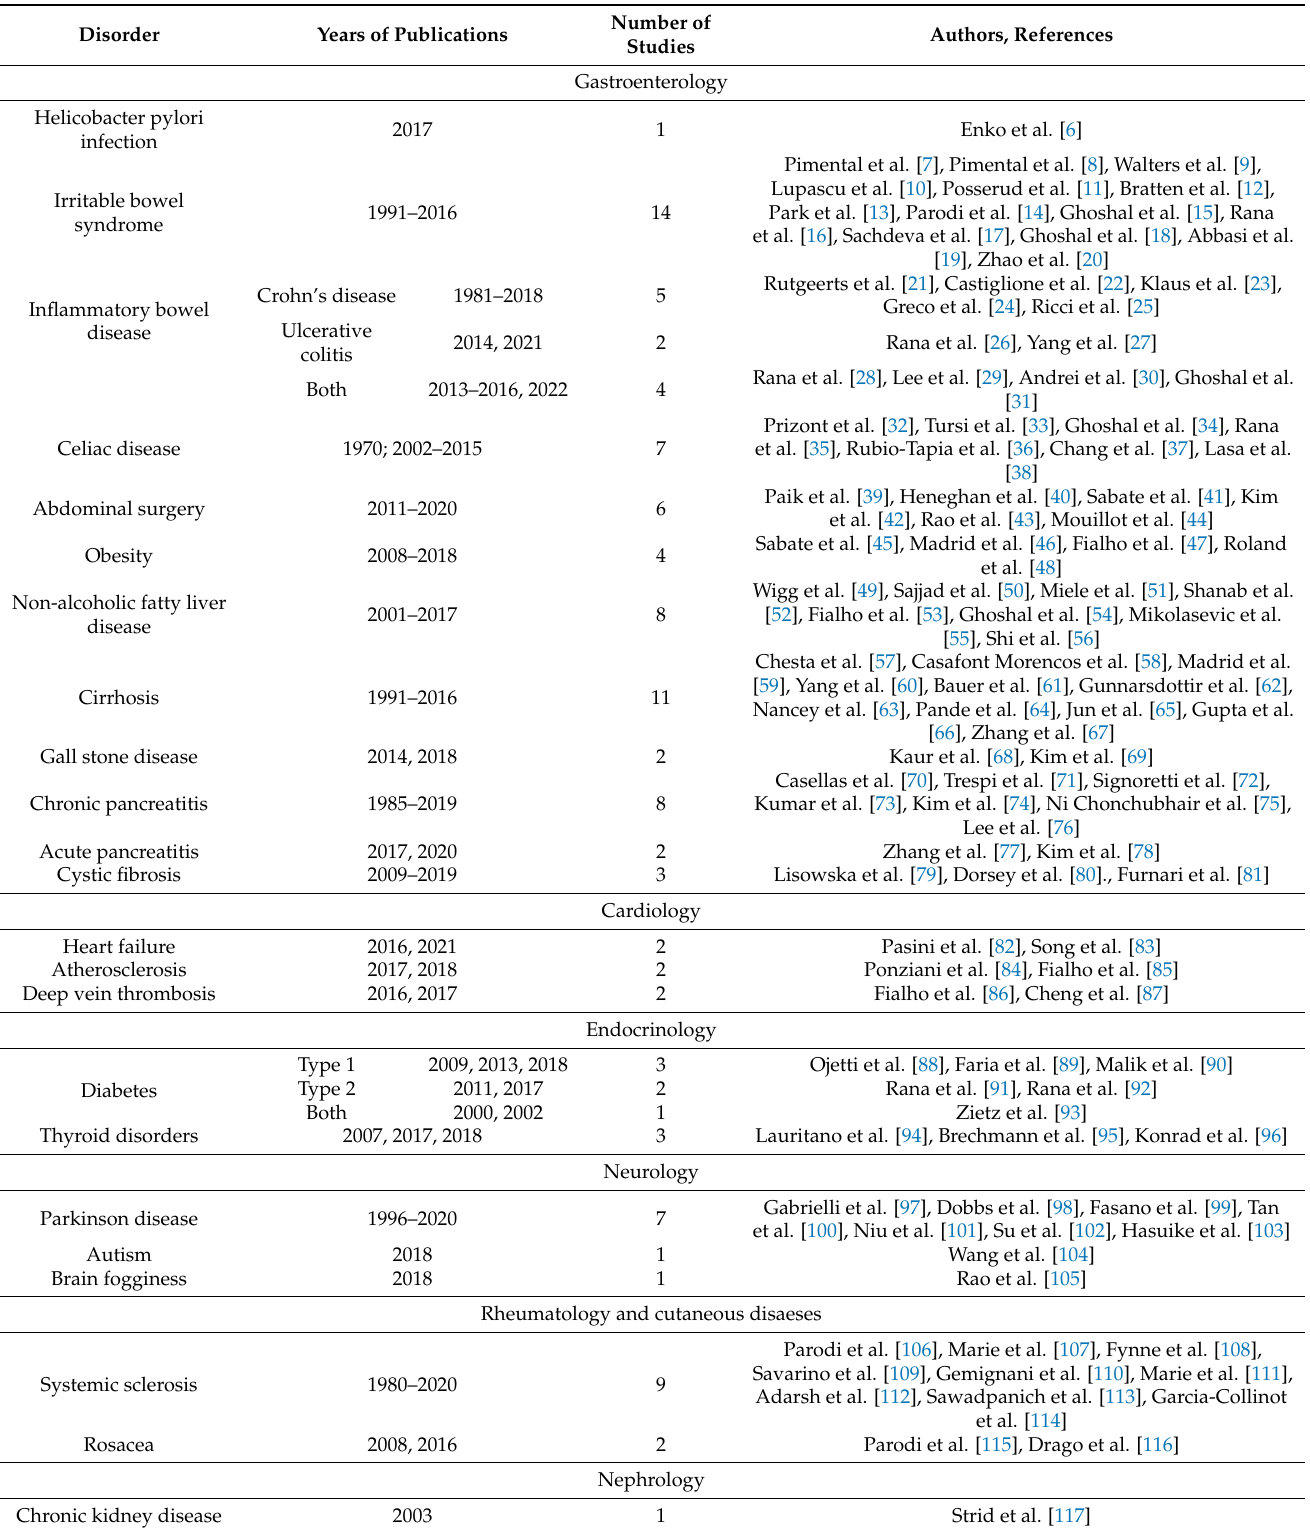
Table 1. Original studies investigating the co-existence of SIBO with different